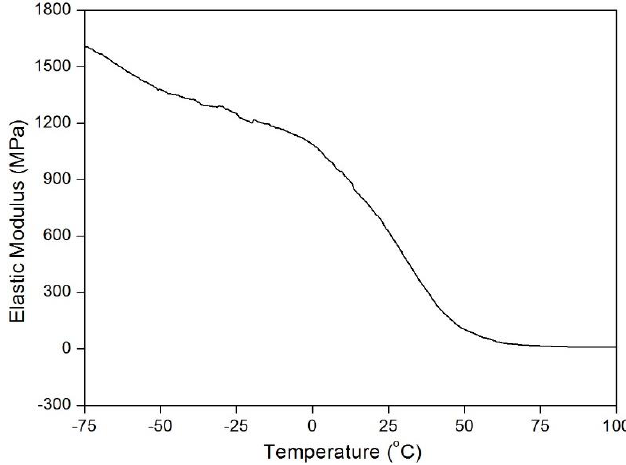
Figure 1. Variation of elastic modulus vs. temperature of the MP using DMA.